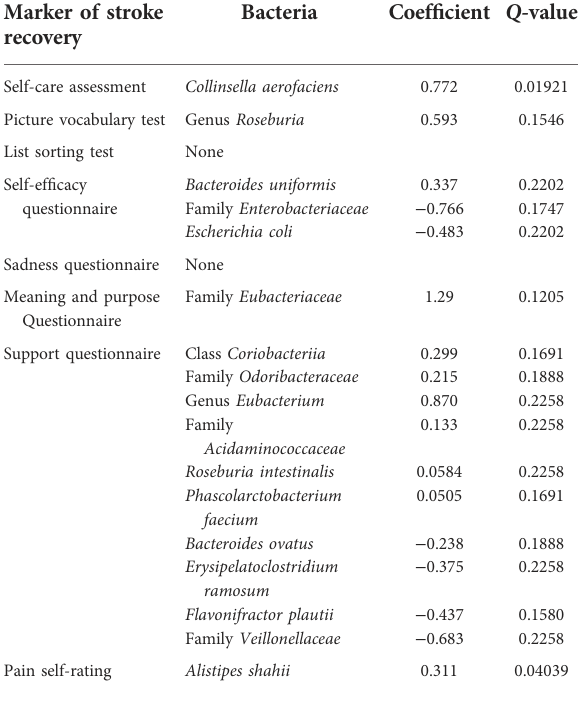
TABLE 4 Microbial taxa correlated with markers of stroke